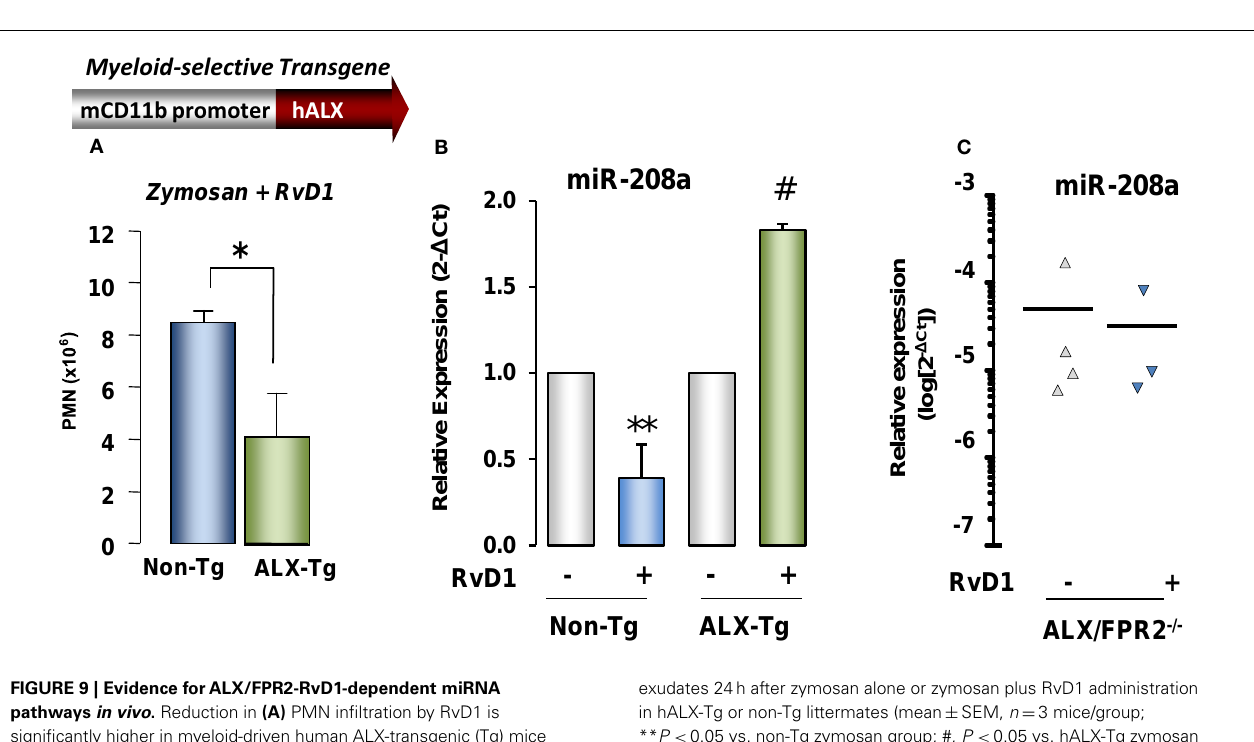
FIGURE 9 | Evidence forALX/FPR2-RvD1-dependent miRNA pathways in vivo . Reduction in (A) PMN infiltration by RvD1 is significantly higher in myeloid-driven human ALX-transgenic (Tg) mice challenged with zymosan (1mg/mouse, i.p., 24h) than non-Tg littermates. Results are mean ± SEM from three mice/group (* P < 0.05 vs. non-Tg). (B) Relative expression of miR-208a determined in resolving